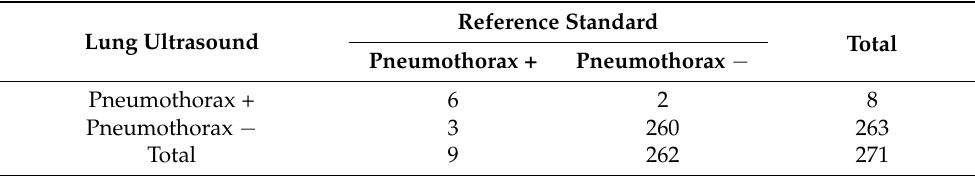
Table 4. Post-procedural lung ultrasound compared to the reference standard: 2 × 2